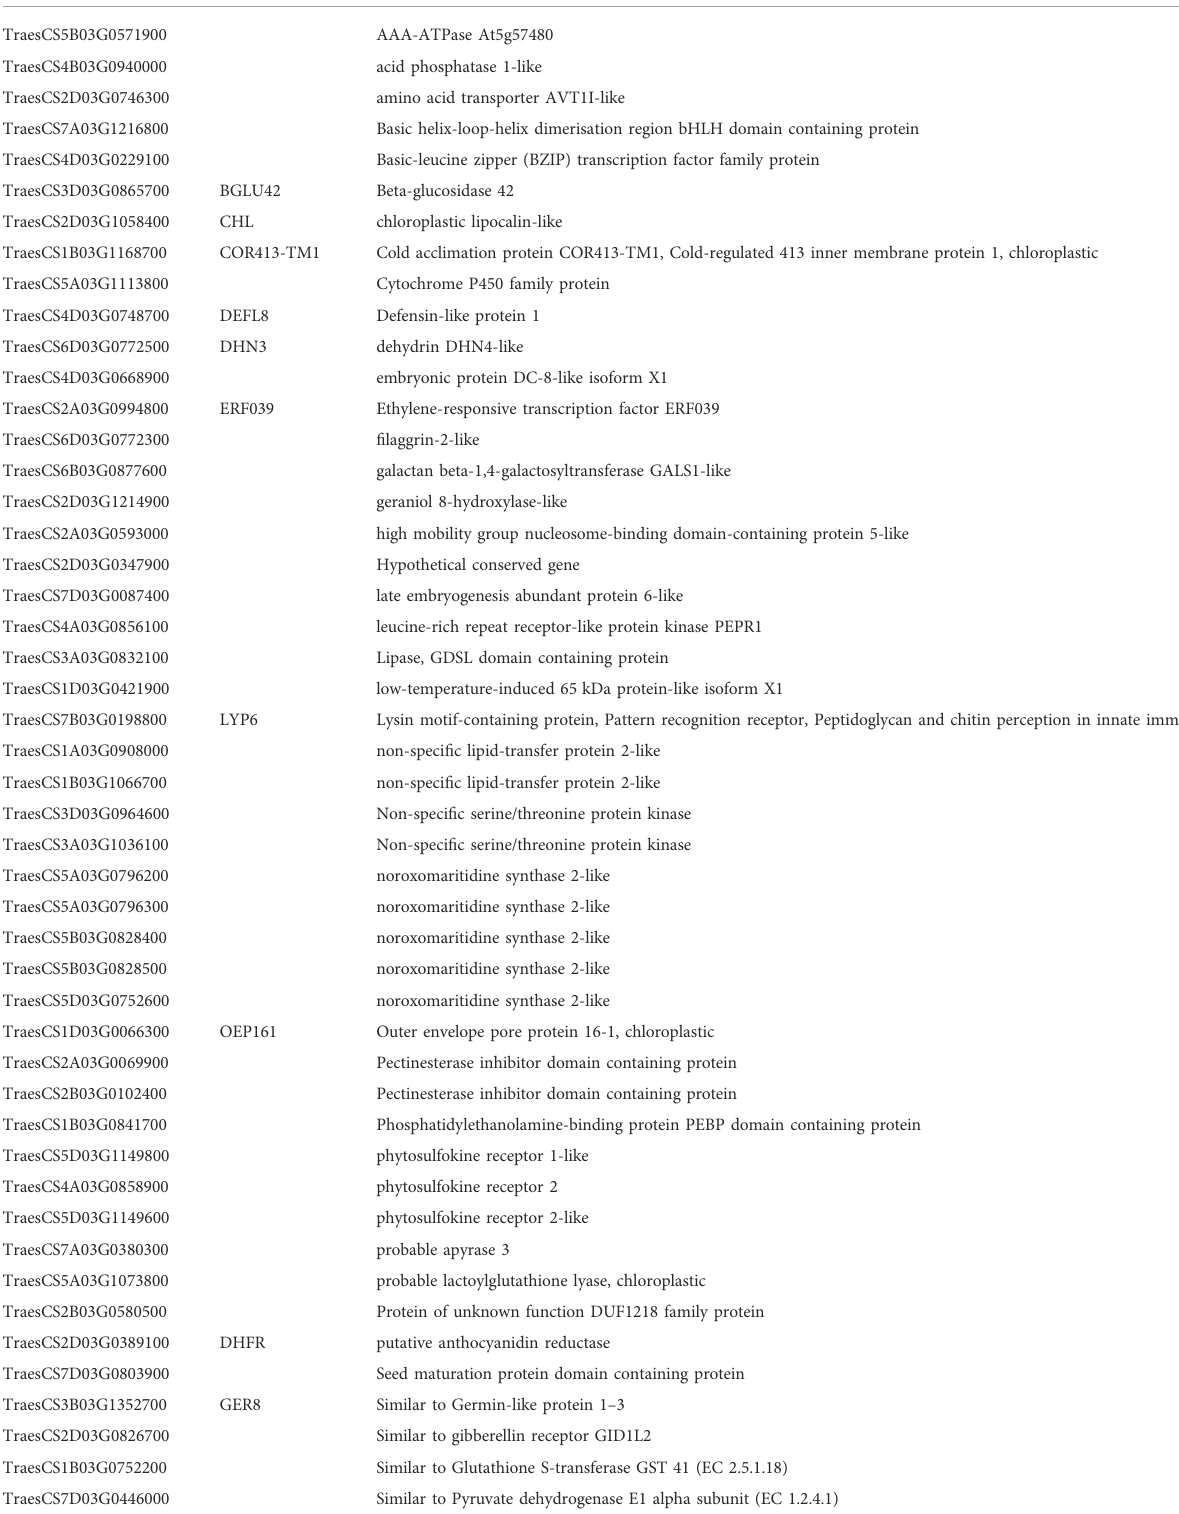
TABLE 2 Winter-habit